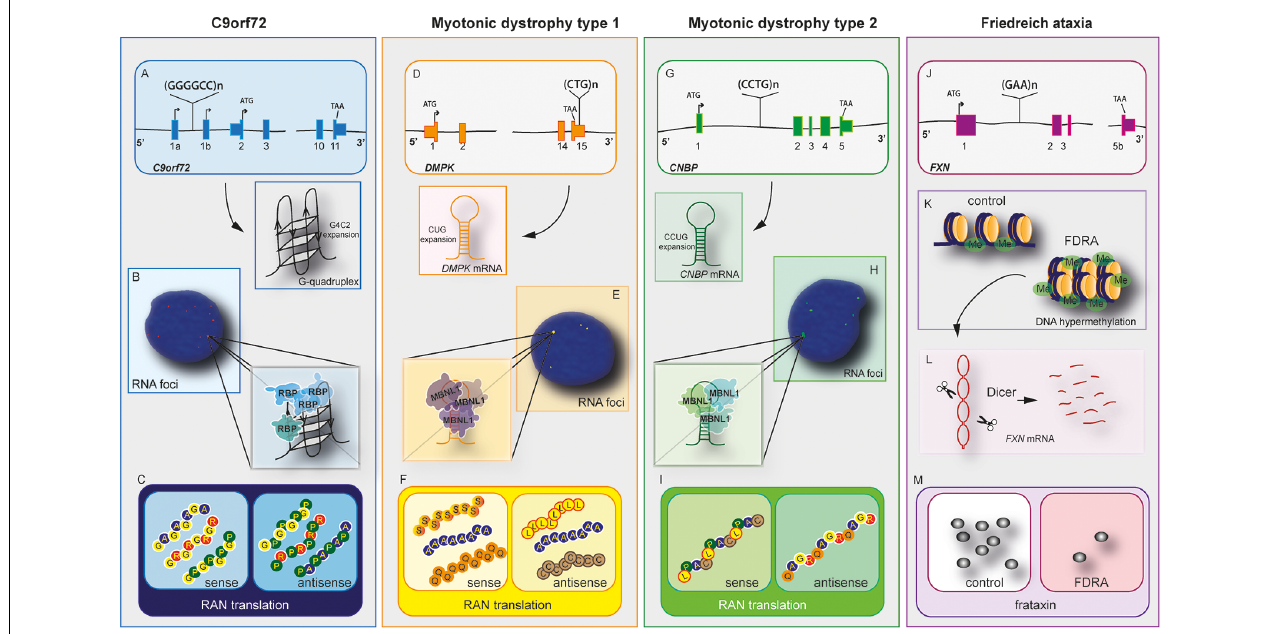
FIGURE 1 | C9orf72 and other repeat expansion disease mechanisms. Nucleotide repeat expansions located at intron or untranslated regions (UTRs) cause three main disease-related features, haploinsufficiency in C9orf72 (A) , myotonic Dystrophy type 1 (DM1; D ), myotonic dystrophy type 2 (G) , and Friedreich’s ataxia (FRDA) (J) . mRNAs containing repeat expansions form G-quadruplex (C9orf72) and RNA hairpin structures (myotonic dystrophy type 1 and 2). These RNA hairpins will accumulate and form RNA foci (B,E,H) , which will sequester RNA binding proteins (RBPs) including hnRNP-H in C9orf72 and Muscleblind like Splicing Regulator 1 (MBNL1) in myotonic dystrophy type 1 and 2. Repeat-associated non-AUG (RAN) translation produces peptides from the sense and antisense strands in C9orf72 (C) , myotonic dystrophy type 1 (F) , and myotonic dystrophy type 2 (I) . The exception lies in FRDA disease mechanisms. In this disease, the repeat expansion causes DNA hypermethylation and gene expression dysregulation of neighboring genes (K) . The mRNA forms hairpins, which are degraded by Dicer (L) , leading to downregulation of frataxin (M) . In this disease, RNA foci and RAN translation were not observed.